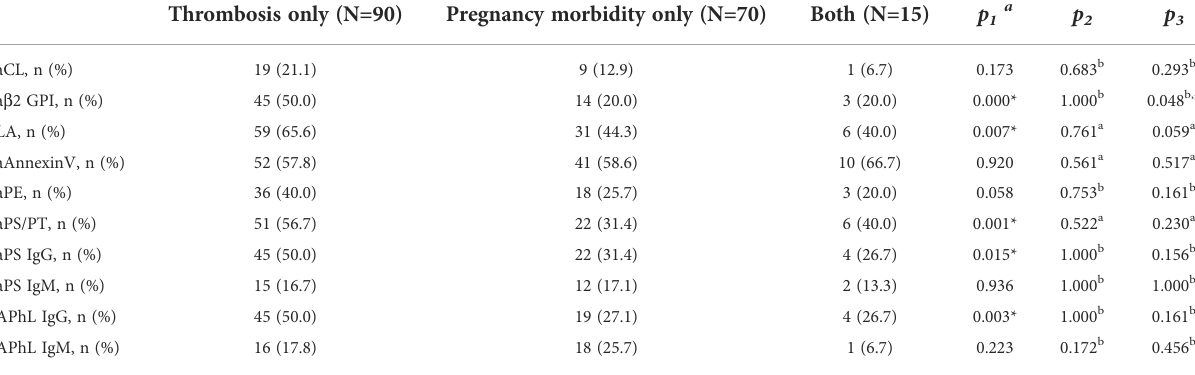
TABLE 4 Prevalence of different antibodies among APS patients with a history of thrombosis only, pregnancy morbidity only, or both. Thrombosis only